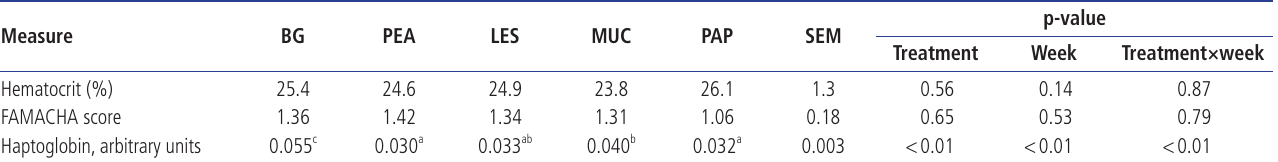
p-value Treatment Week Treatment×week